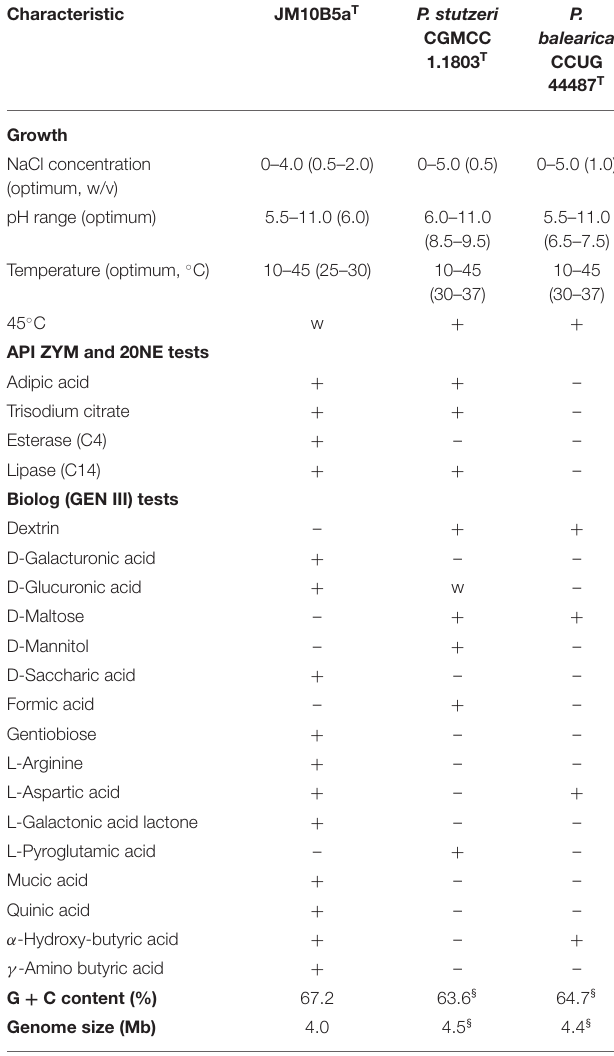
TABLE 1 | Cellular fatty acid profiles of strain JM10B5a T and the closely related type strains of genus Pseudomonas . Fatty acid